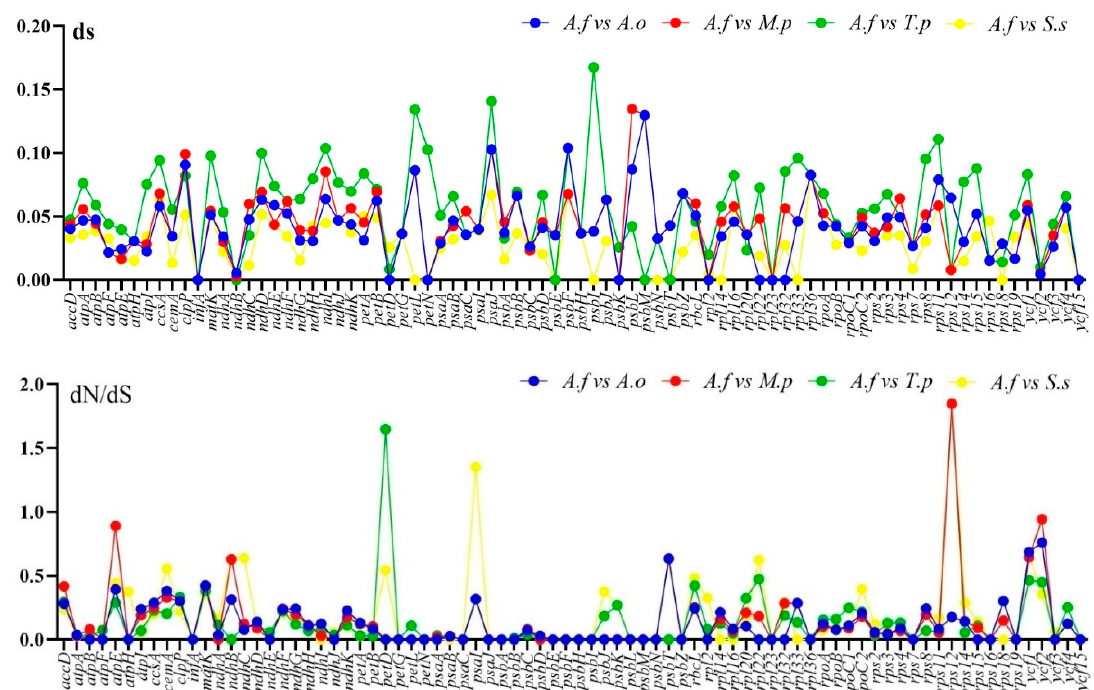
Figure 9. The synonymous (dS) and nonsynonymous (dN)/dS ratio values of 80 protein-coding genes from five Malvaceae cp genomes ( A.f : A. fruticosum ; A.o : A . officinalis ; M.P : M . parviflora ; T.p : T . populnea; S.s : S . szechuensis ).